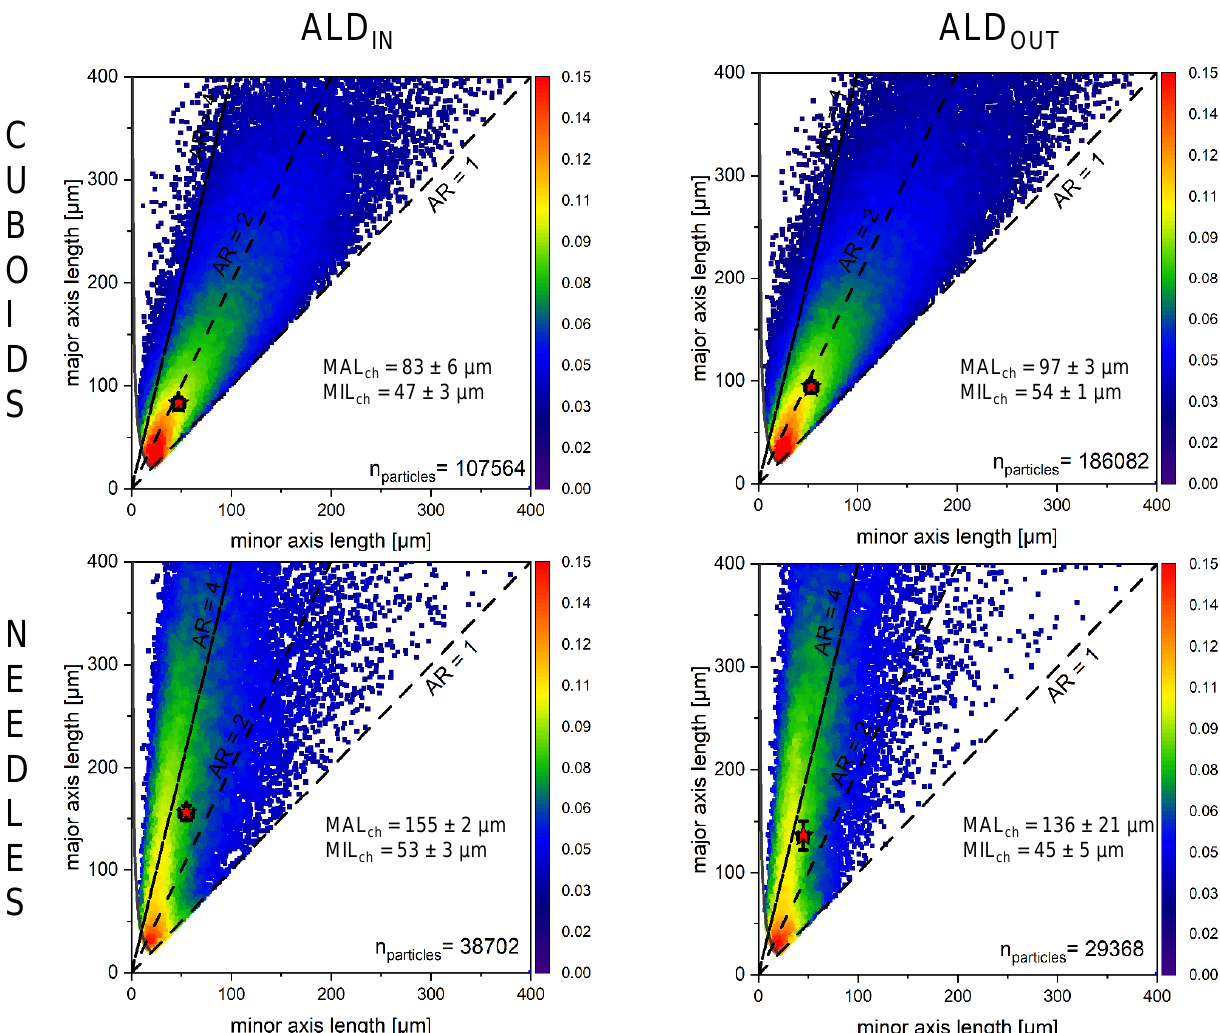
Figure 5. Axis length distribution of the inlet suspension (ALD IN , left) and washed product particles (ALD OUT , right) after two-stage washing: upper half — for cuboid-shaped particles with an average aspect ratio of 2; lower half — for needle-shaped particles with an average aspect ratio of 3 – 4.